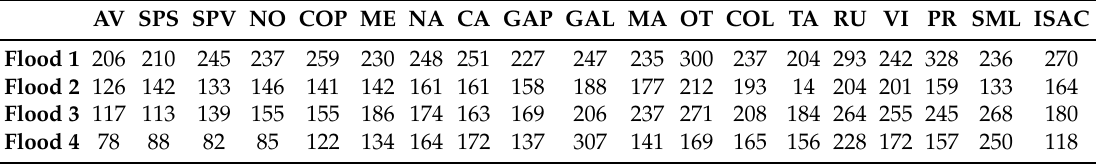
Table 2. Total precipitation (mm) measured at the ISAC-CNR station and at the rain gauges of Figure 1, during the four floods herein considered; see the